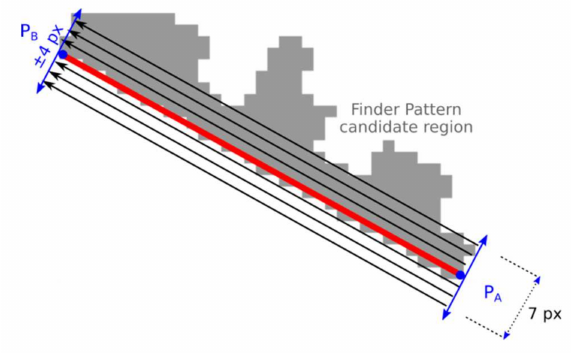
Figure 12. Projection along the line